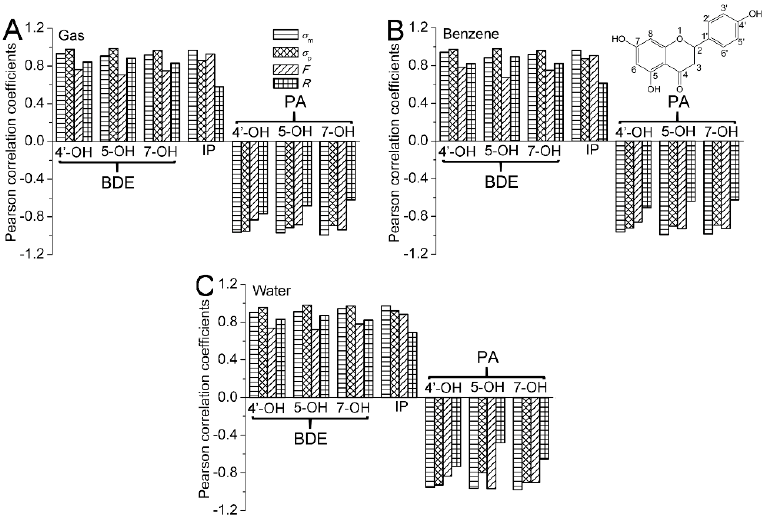
Figure 2. The Pearson correlation coefficients between the Hammett sigma constants ( σ m and σ p )/ F / R and the BDE/ ionization potential (IP)/ ionization potential (PA) in the gas ( A ), benzene ( B ) and water ( C ) phases.